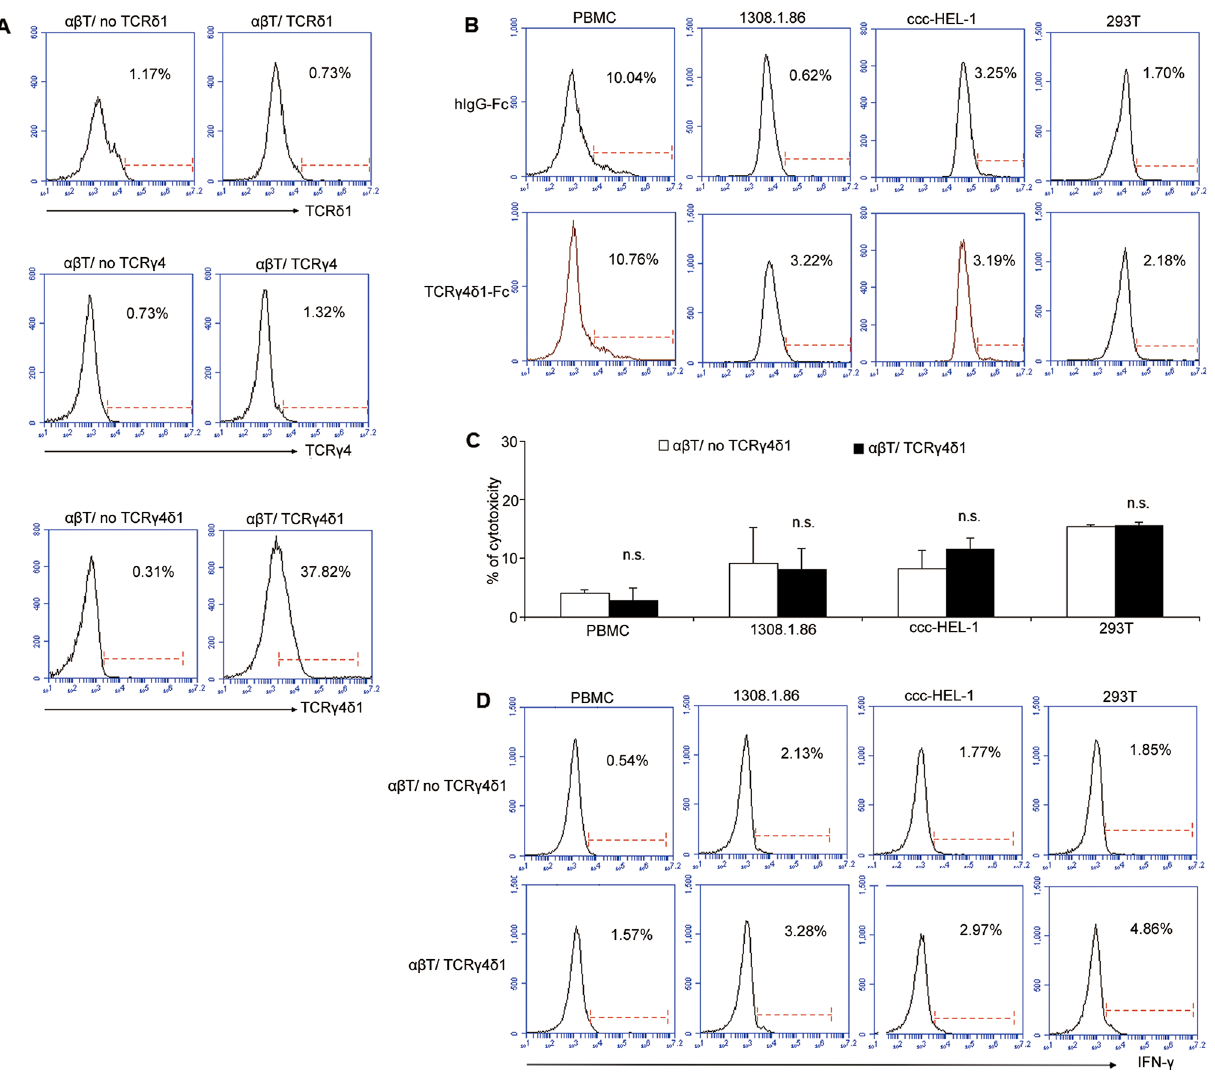
Figure 4. Determination of TCR γ 4 or δ 1 expression and binding/activity to normal cells of TCR g 4 d 1 -engineered αβ T cells. (A) Cell